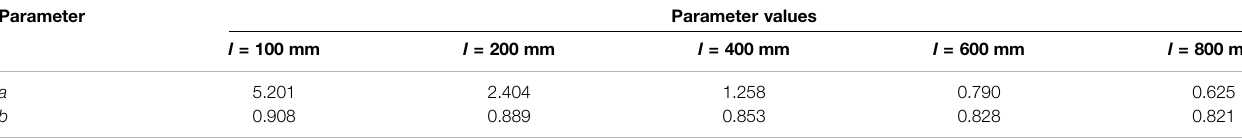
TABLE 3 | Value of parameters a and b of different rock-size.